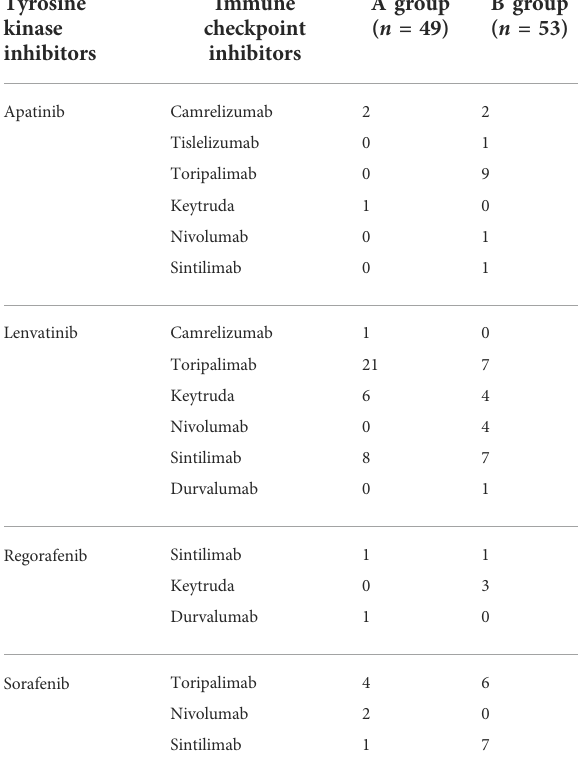
TABLE 1 Initial combination treatment of the